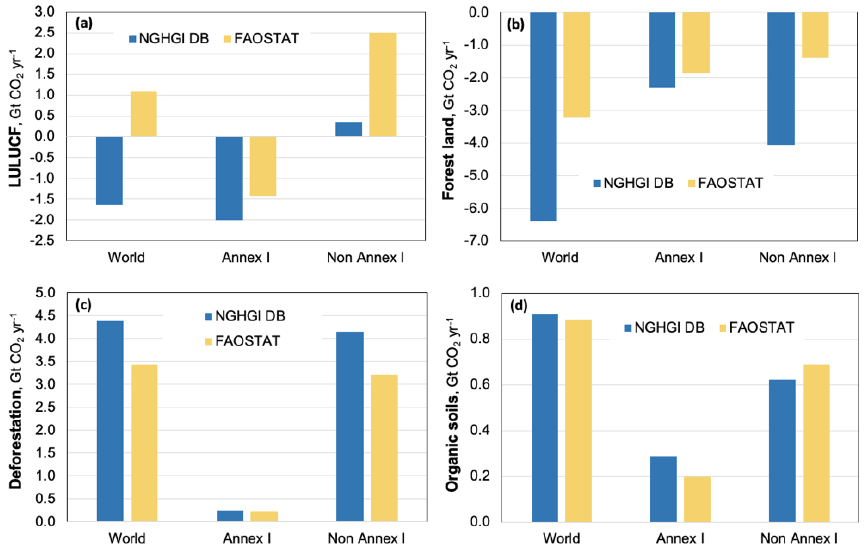
Figure 5. CO 2 fluxes (average 2000–2020) in Annex I and non-Annex I countries from our NGHGI DB and FAOSTAT, for LULUCF (a) , forest land (b) , deforestation ( c , typically gross in NGHGIs and net in FAOSTAT), and organic soils ( d , including peat drainage and peat fires).